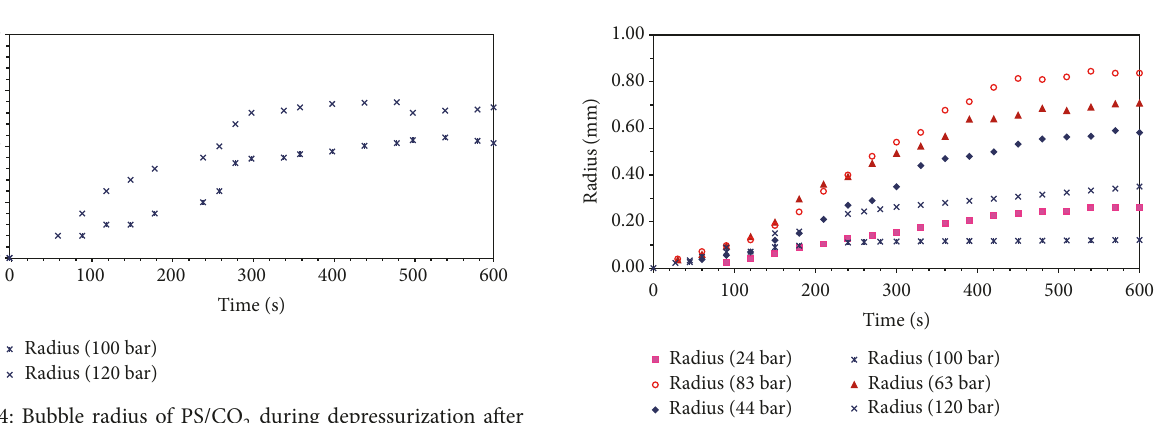
Figure 6: Bubble radius of PS/CO 2 during depressurization after holding at 24 to 120 bar at 100 ∘ C for 2 hours.